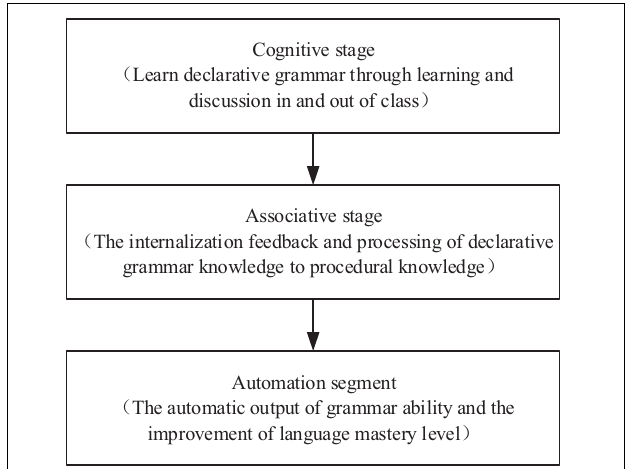
FIGURE 2 | Basic knowledge acquisition of English grammar in a non-native language